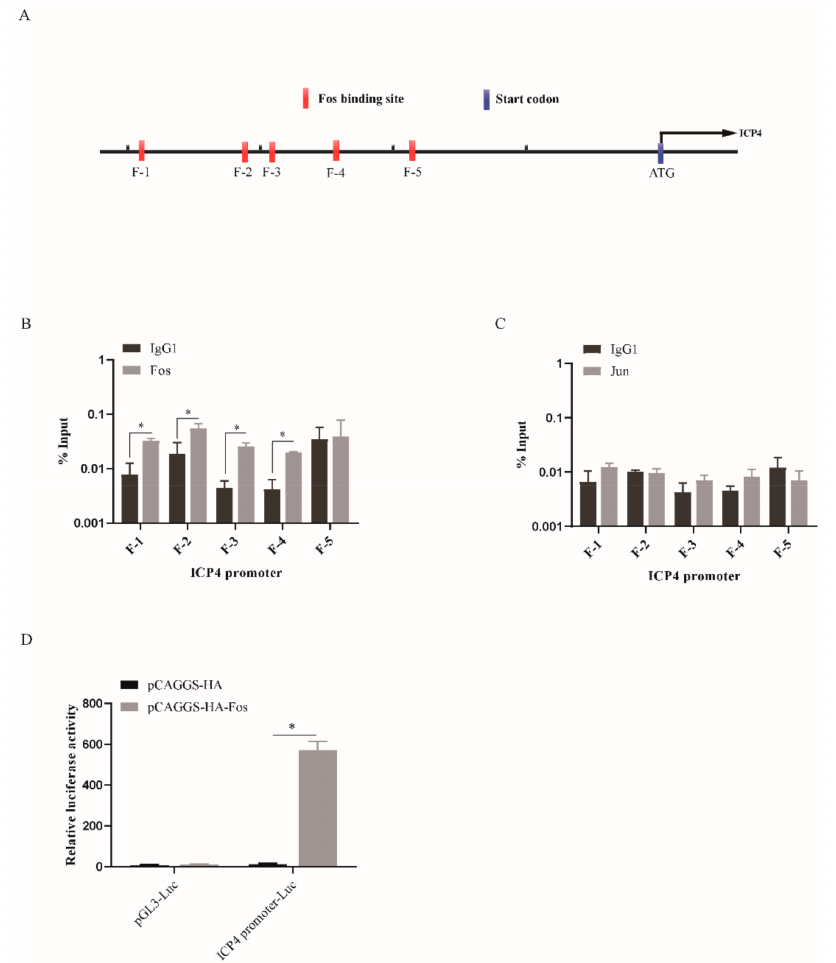
Figure 5. ICP4 is a bona fide target gene of Fos. ( A ) Schematic representation of the putative binding sites of Fos (F-1, F-2, F-3, F-4, F-5) in the promoter region of ICP4 . ( B , C ) LMH cells were